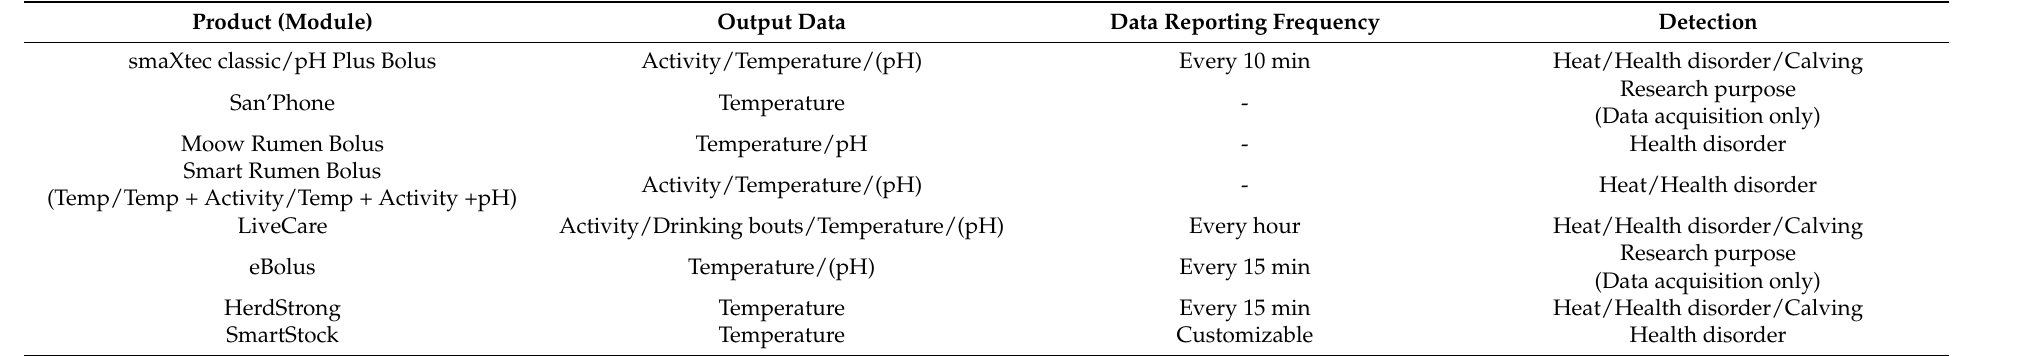
Table 6. Output data and detection items of the wearable wireless biosensor systems (rumen bolus